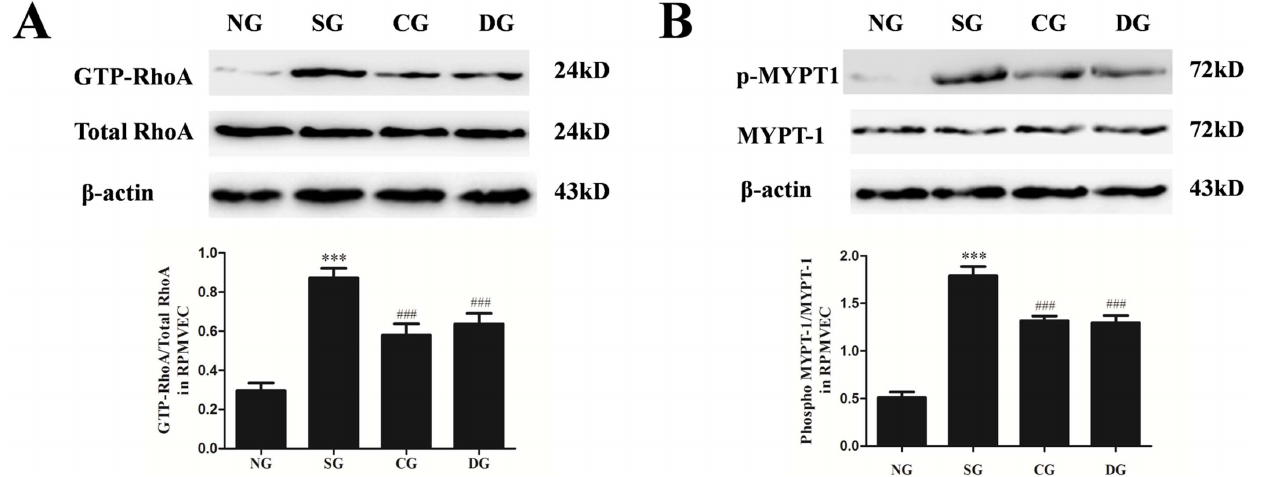
Figure 5. Effects of calcitriol on RhoA/ROCK pathway in RPMVECs. Proteins were obtained at 4 h after seawater administration. The ratios of GTP-RhoA versus total-RhoA and p-MYPT1 versus MYPT1 were obtained for each group to examine the GTP-RhoA (A) and p-MYPT1 (B) contents. NG: normal group; SG: seawater group; CG: 10 2 6 M calcitriol group; DG: dexamethasone group. n=6, ***P , 0.001 versus group NG, ### P , 0.001 versus group SG.